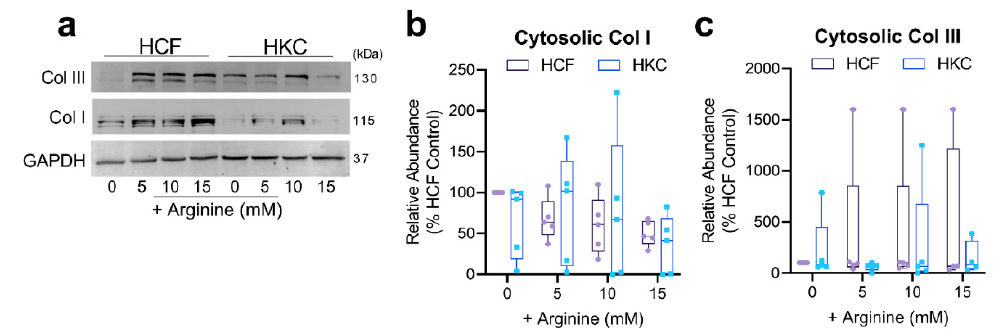
Figure 6. Cytosolic collagen protein expression. ( a ) Representative Western blots and ( b , c ) quantification of cytosolic collagen type I (Col I) and collagen type III (Col III) protein expression in HCFs and HKCs. Statistical significance evaluated based on a two-way ANOVA with Sidak’s multiple comparisons based on n > 3.